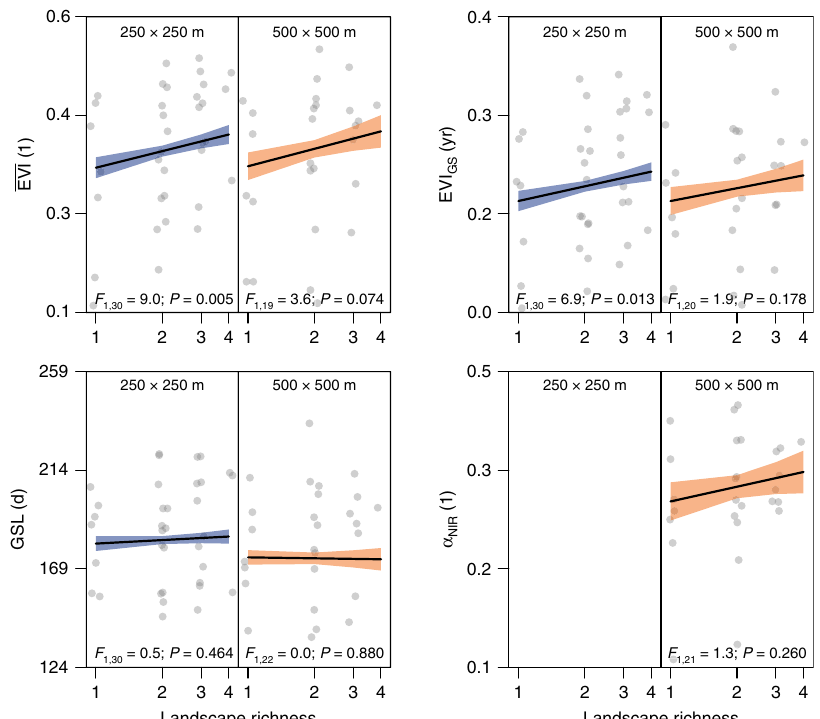
Fig. 2 Effects of landscape richness on landscape functioning variables. Productivity: growing-season mean enhanced vegetation index ( EVI ), growing- season integrated enhanced vegetation index (EVI GS ); Phenology: growing-season length (GSL); Albedo: near-infrared range ( α NIR , 500 × 500 m landscape plots only); black line and shaded areas: model-predicted mean ± s.e.m.; F : F -ratio with associated degrees of freedom; P : P -value. Symbols indicate averages for each land-cover composition. Note the log-transformed axis for landscape richness ( n = 237 and 77 for 250 × 250m and 500 × 500 m land- cover composition × block combinations, respectively). Source data are provided as a Source Data fi le. Table 1 Net diversity effects (NE) on productivity, phenology and albedo. Category Landscape Landscape size NE>0 effect NE>0 effect signi fi cance Linear effect of log(LR) Linear effect of log(LR) on NE function (mean±s.e.m.) a (one-sample t -test) a on NE (mean±s.e.m.) a signi fi cance ( F -test) a Productivity